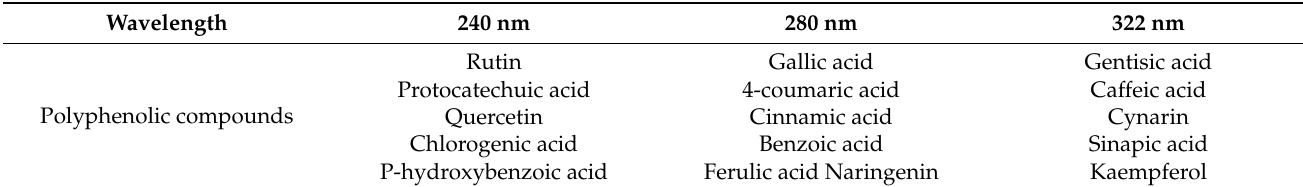
Table 1. Detection of different polyphenolic components by HPLC at different wavelengths.